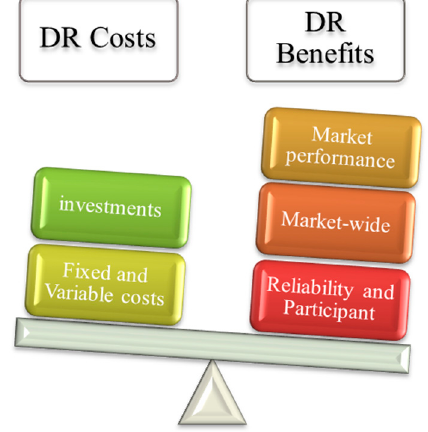
Figure 9. Classification DR costs and benefits for system operators at one look.